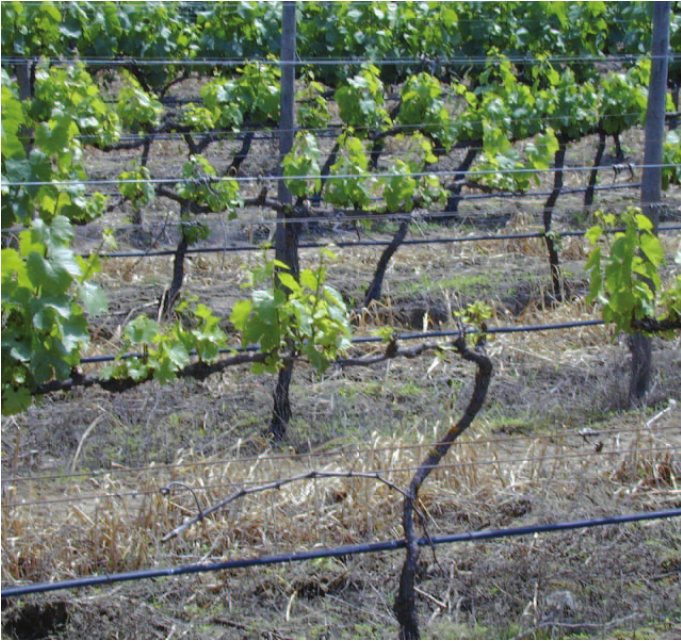
Fig. 2. Cross-section through a black foot dis- ease infected rootstock revealing severe necro- sis extending from the bark to the pith.